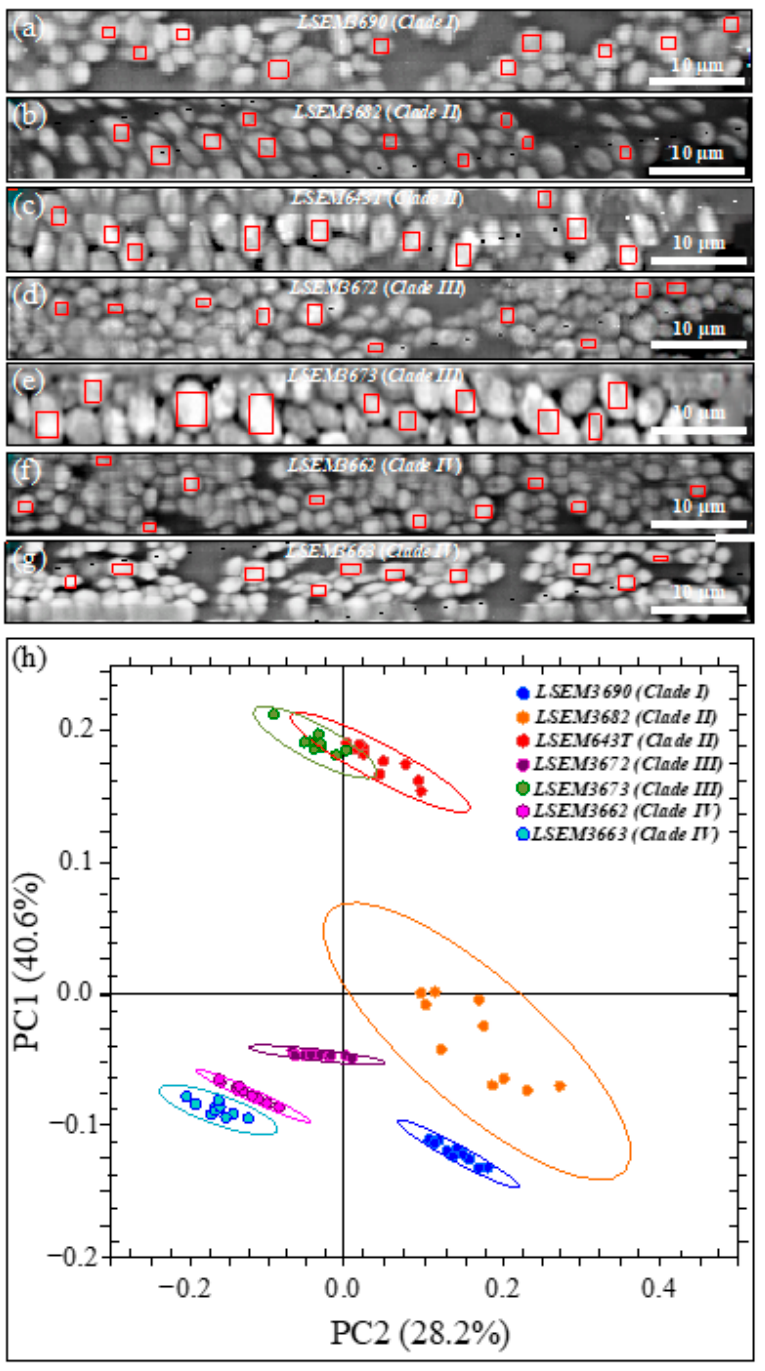
Figure 11. Images of the seven C. auris samples investigated ( a – g ) (cf. labels in inset). On each map, ten locations 10~20 µ m 2 in size are selected, in which 200~400 Raman spectra are collected and averaged to obtain a representative spectrum for each selected location; ( h ) PCA analyses of 10 average spectra in the Raman spectral region 300~1800 cm − 1